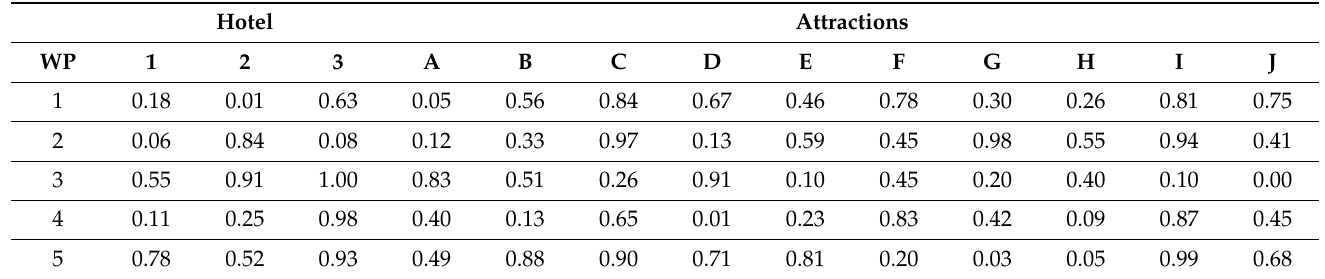
Table 1. The initial set of work packages includes five WPs that are chosen at